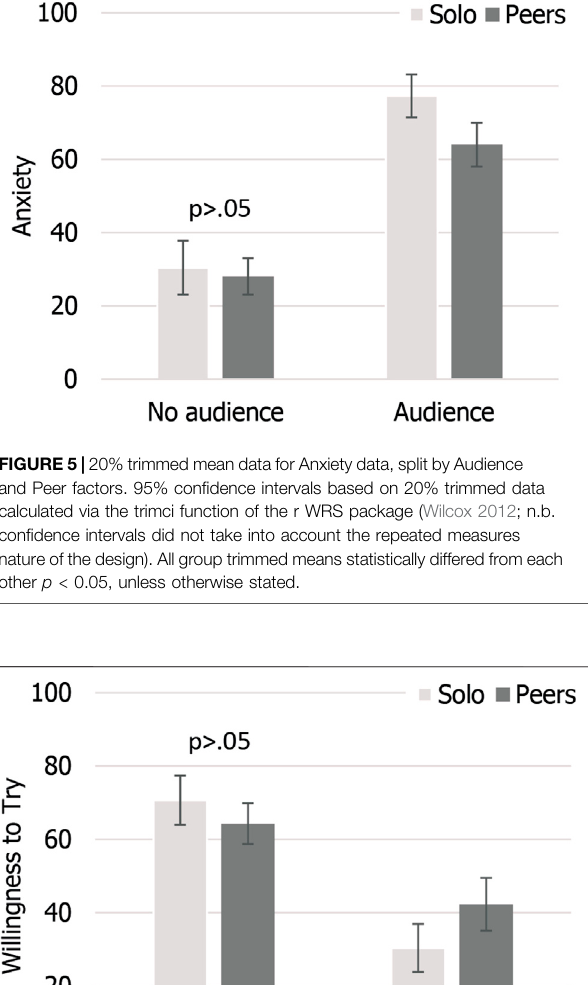
Frontiers in Virtual Reality |